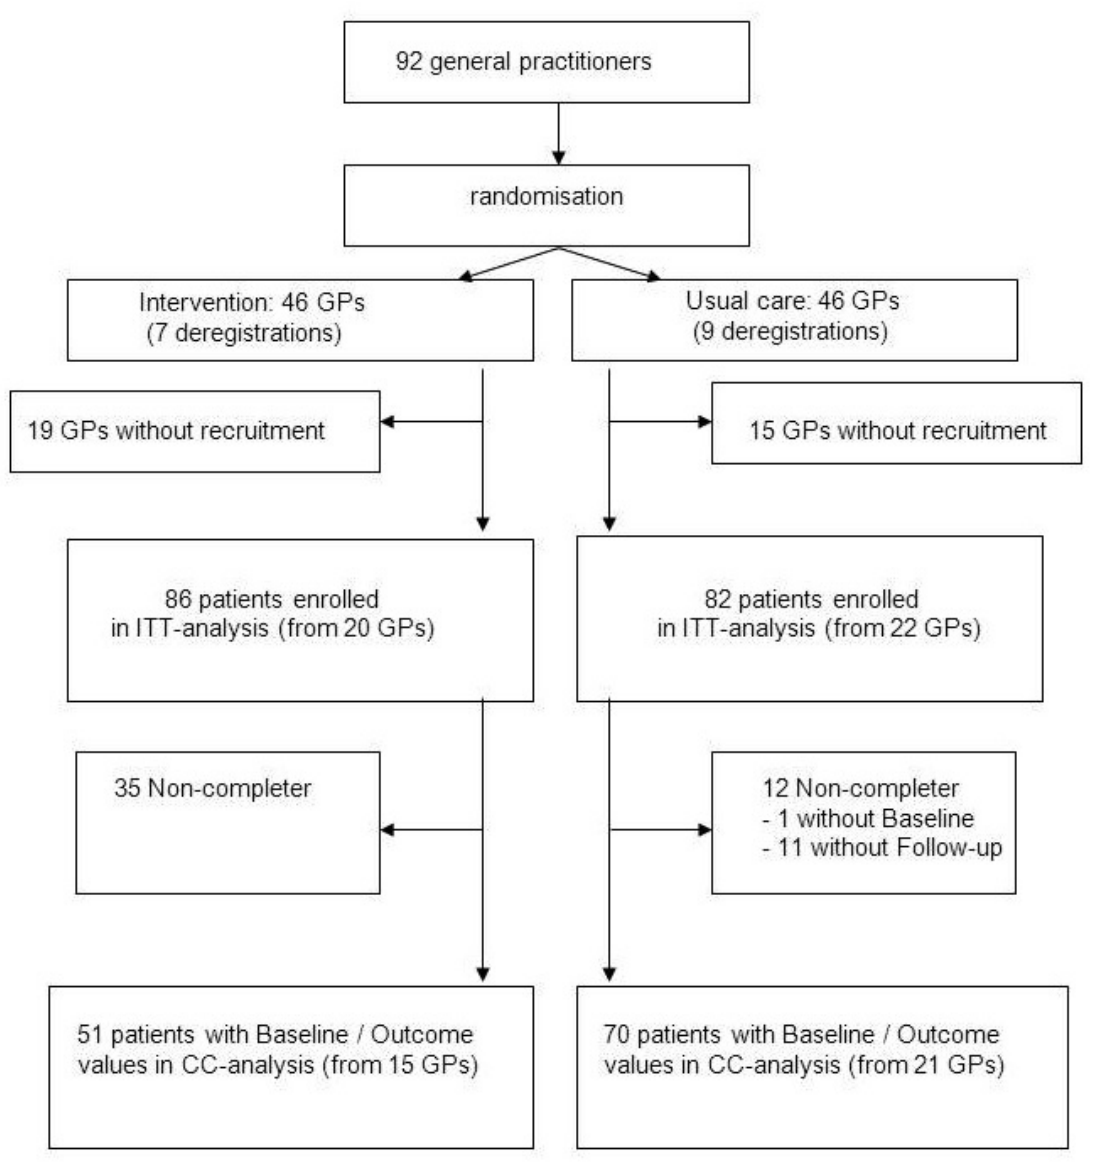
Figure 3. Participant flow of the study (GP=general practitioner; ITT=intent-to-treat;